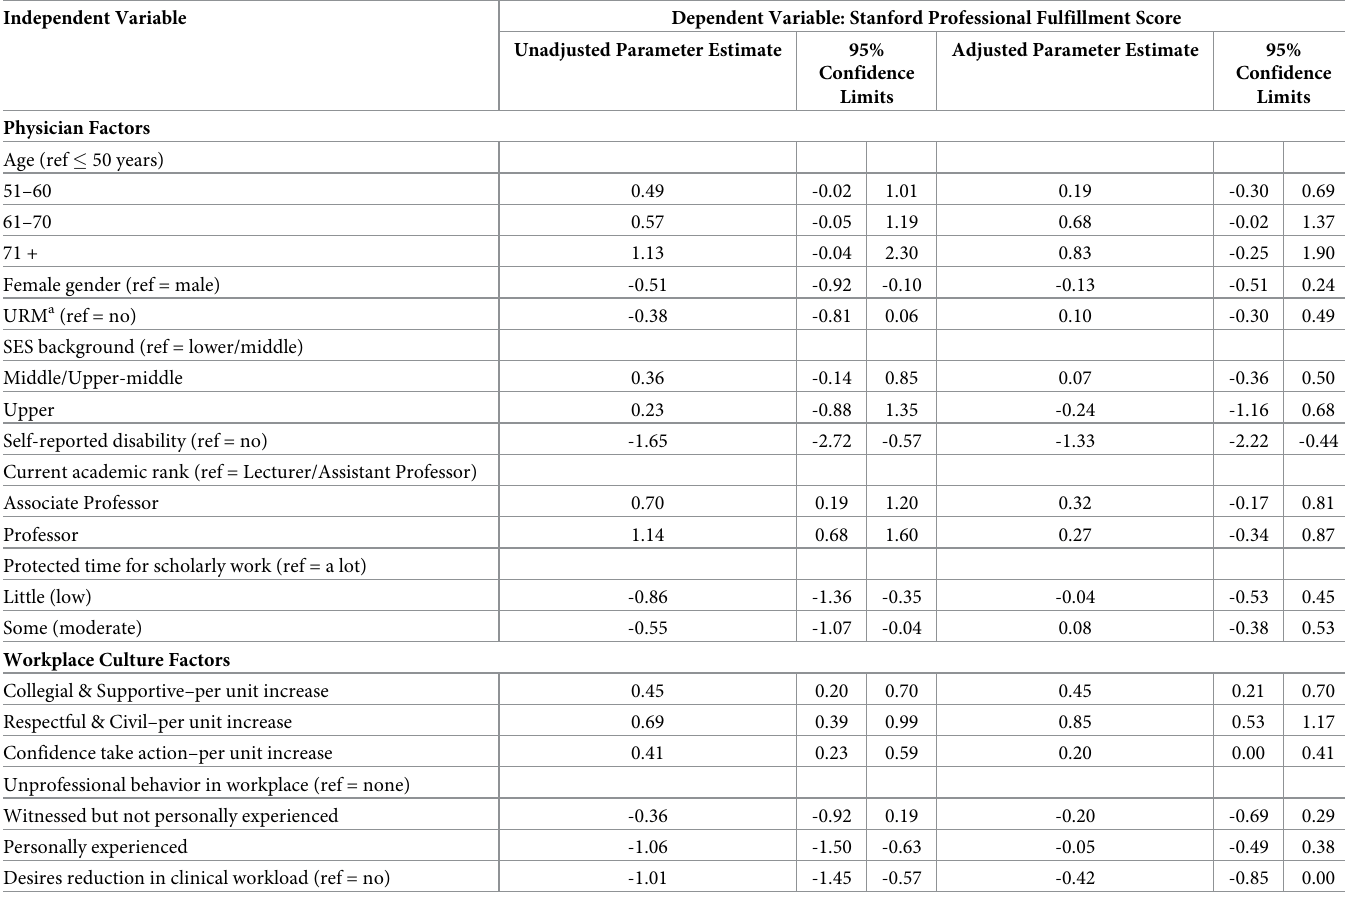
Table 3. Relationship of physician and organization factors to professional fulfillment–results of linear regression